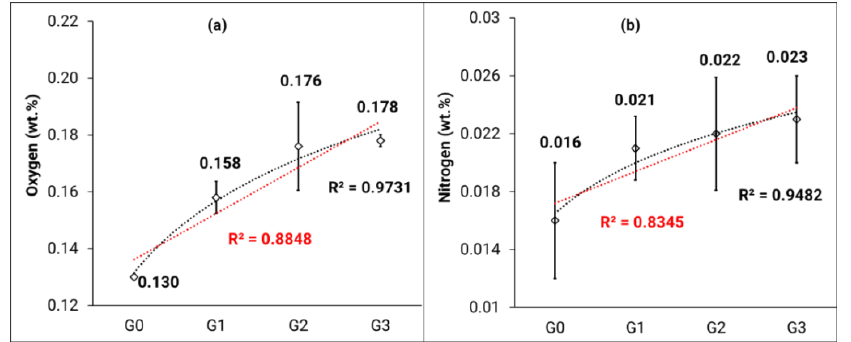
Figure 7. ( a ) Oxygen and ( b ) nitrogen concentration for G 0 , G 1 , G 2 , and G 3 powder types along with linear (in red) and logarithmic (in black) trendlines. Error bars represent the standard deviation.